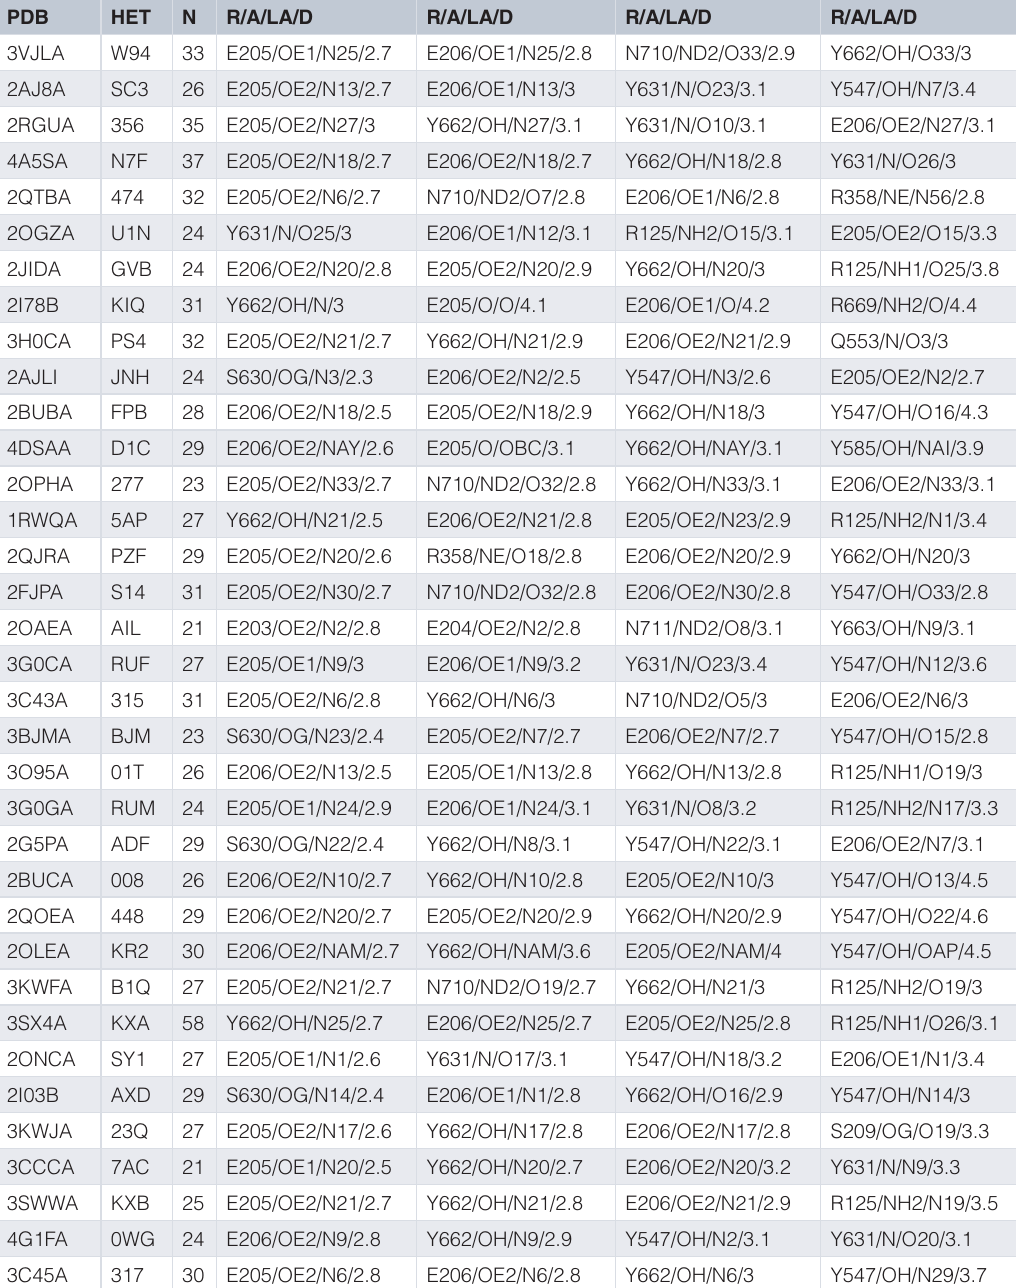
Supplementary Table 2. Residues of DPP4 closest to the bound ligand with possible hydrogen bonds. Interactions sorted based on the distance. N: Number of atoms in the ligand, R/A/LA/D: Residue number/Atom of the residue/Atom of ligand/distance between the interacting atoms (in Å). For example, ‘E205/OE1/N25/2.7’ means that the atom OE1 from Glu205 is at 2.7 Å from the N25 atom of W94 in PDBid:3VJLA. For uniformity, we choose the first four closest atoms. This might result in choosing some atoms which are unlikely to form a hydrogen bond (for example, in PDBid:4J3JA S209/OG is at 4.8 Å from